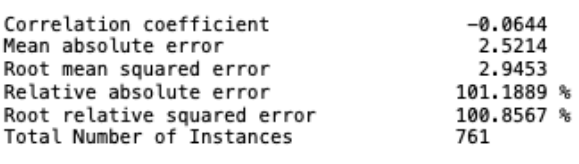
Figure 5. Gaussian processes for 761 works in three clusters: plasticity, memory and